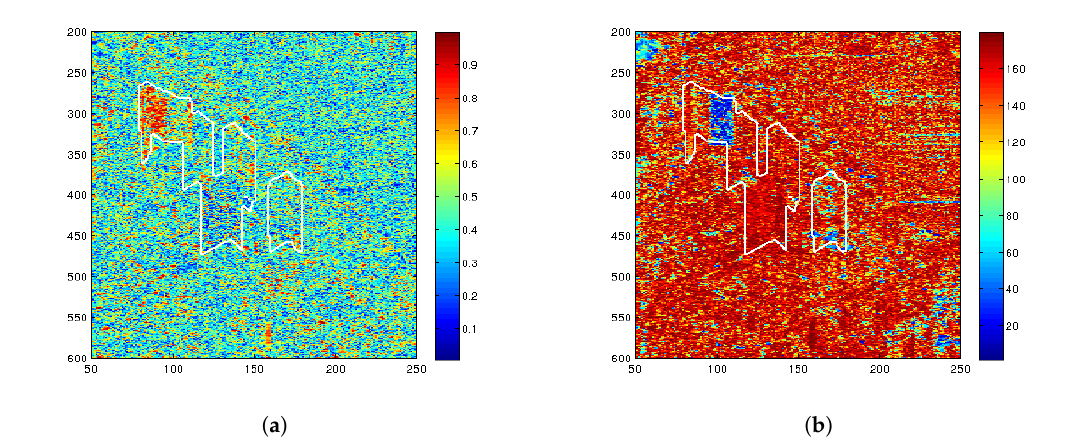
Figure 18. Difference of ( a ) diattenuation and ( b ) retardance for the five different